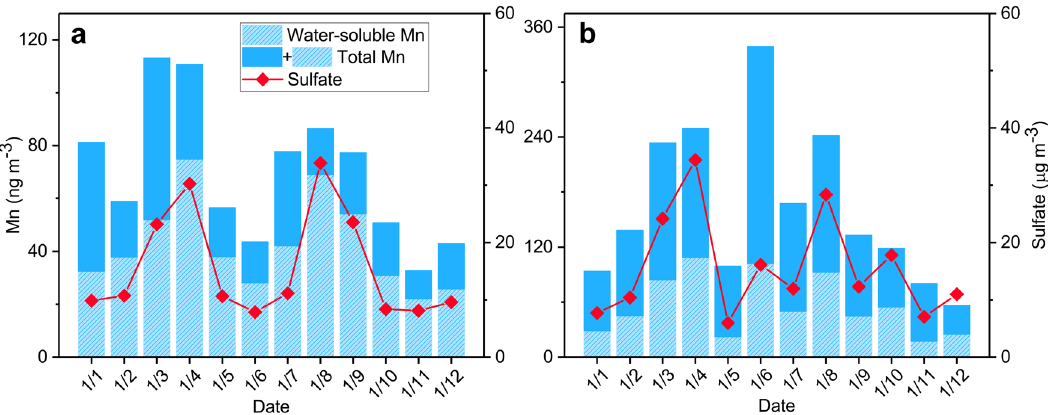
Fig. 5 Temporal variation of water-soluble Mn, total Mn, and sulfate concentration in PM 2.5 in the North China Plain (Baoding and Tianjin) from January 1 – 12, 2015. a Refers to Baoding, and b refers to Tianjin. Metal ions and sulfate concentration were measured by inductively coupled plasma mass spectrometry and ion chromatography,